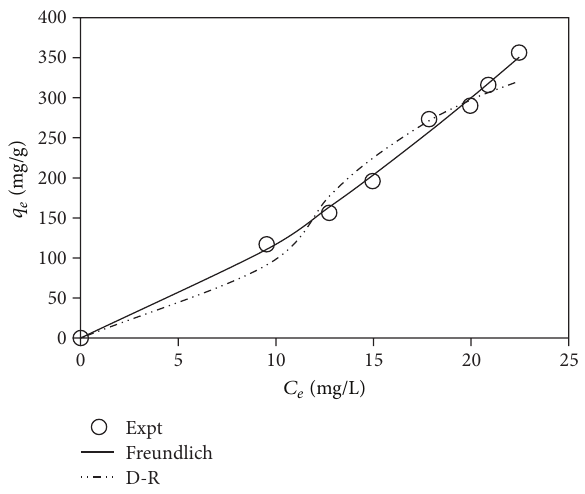
Figure 8: Adsorption isotherm for sorption of glutaraldehyde on EDA-AC: 298 K; 0.8 g/L AC; pH 11.6 ± 0.2 ; − 425 + 150 𝜇 m.